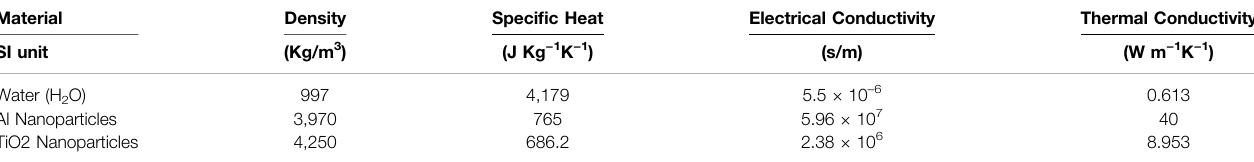
TABLE 2 | Numerical values for various physical and chemical properties [48, 49]. Material Density Electrical Conductivity Thermal